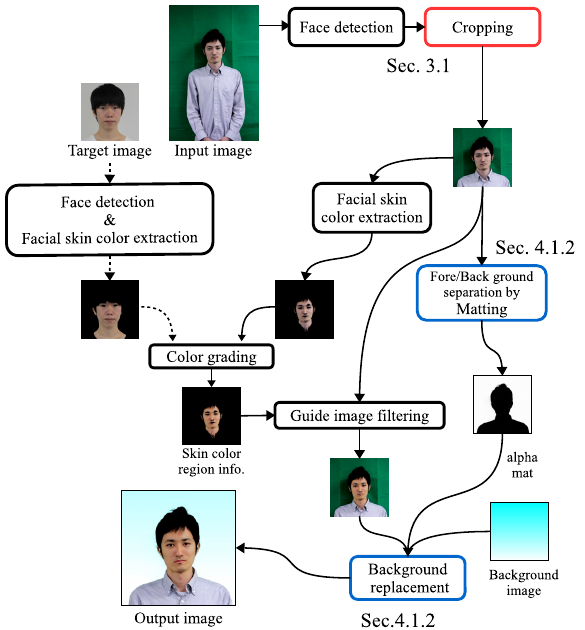
Figure 9. Flow chart of auto yearbook style photo generation. The red box indicates a pre-processing procedure, and the blue boxes indicate a post-processing procedure.